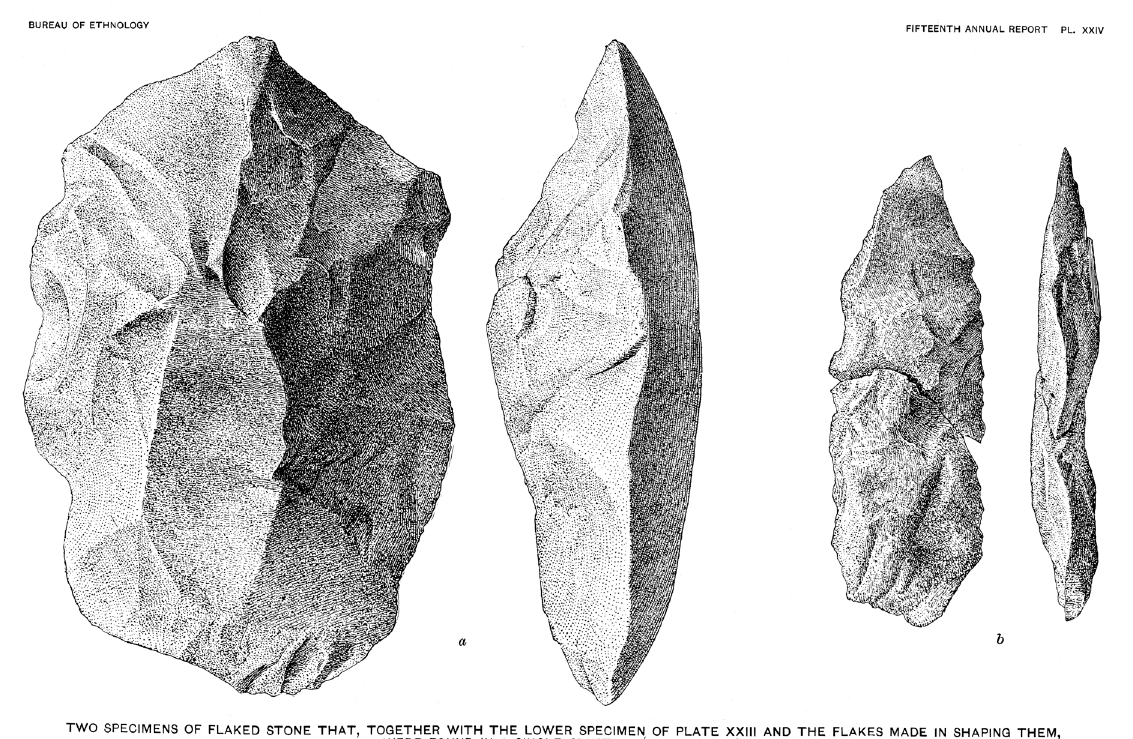
Figure 4. Paleolith and leaf-blade from Piney Branch. The piece on the left is 10-12 cm in length. After Holmes (1897: plate XXIV). [Original caption: Two specimens of flaked stone that, together with the lower specimen of Plate XXIII and the flakes made in shaping them, were found in a single cluster (actual